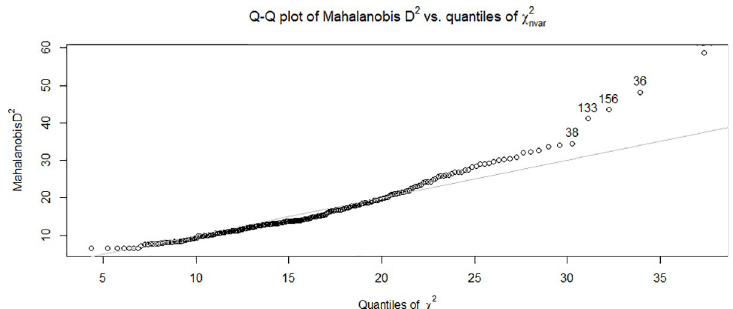
Fig 4. Quantile-Quantile (Q-Q) plot describing squared Mahalanobis distance (y-axis) against the quantiles of the chi- square distribution (x-axis).